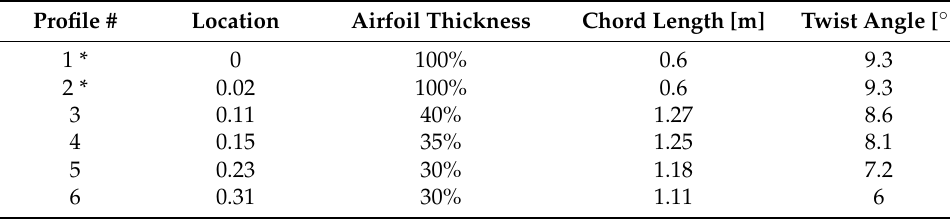
Figure 2. The 13 m wind turbine blades. Table 1. Geometric section parameters of the reference 13 m wind turbine blade.